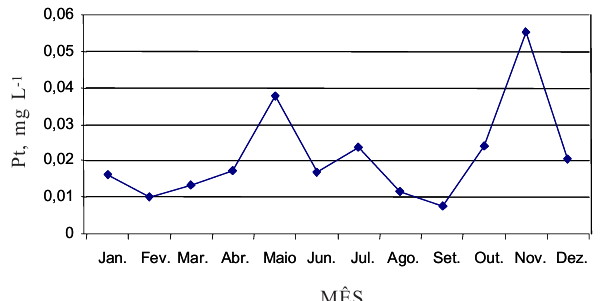
Figura 3. Resultado da simulação matemática do cenário A1, no ano de 2006, para a concentração mensal de P total (Pt) no reservatório Piraquara